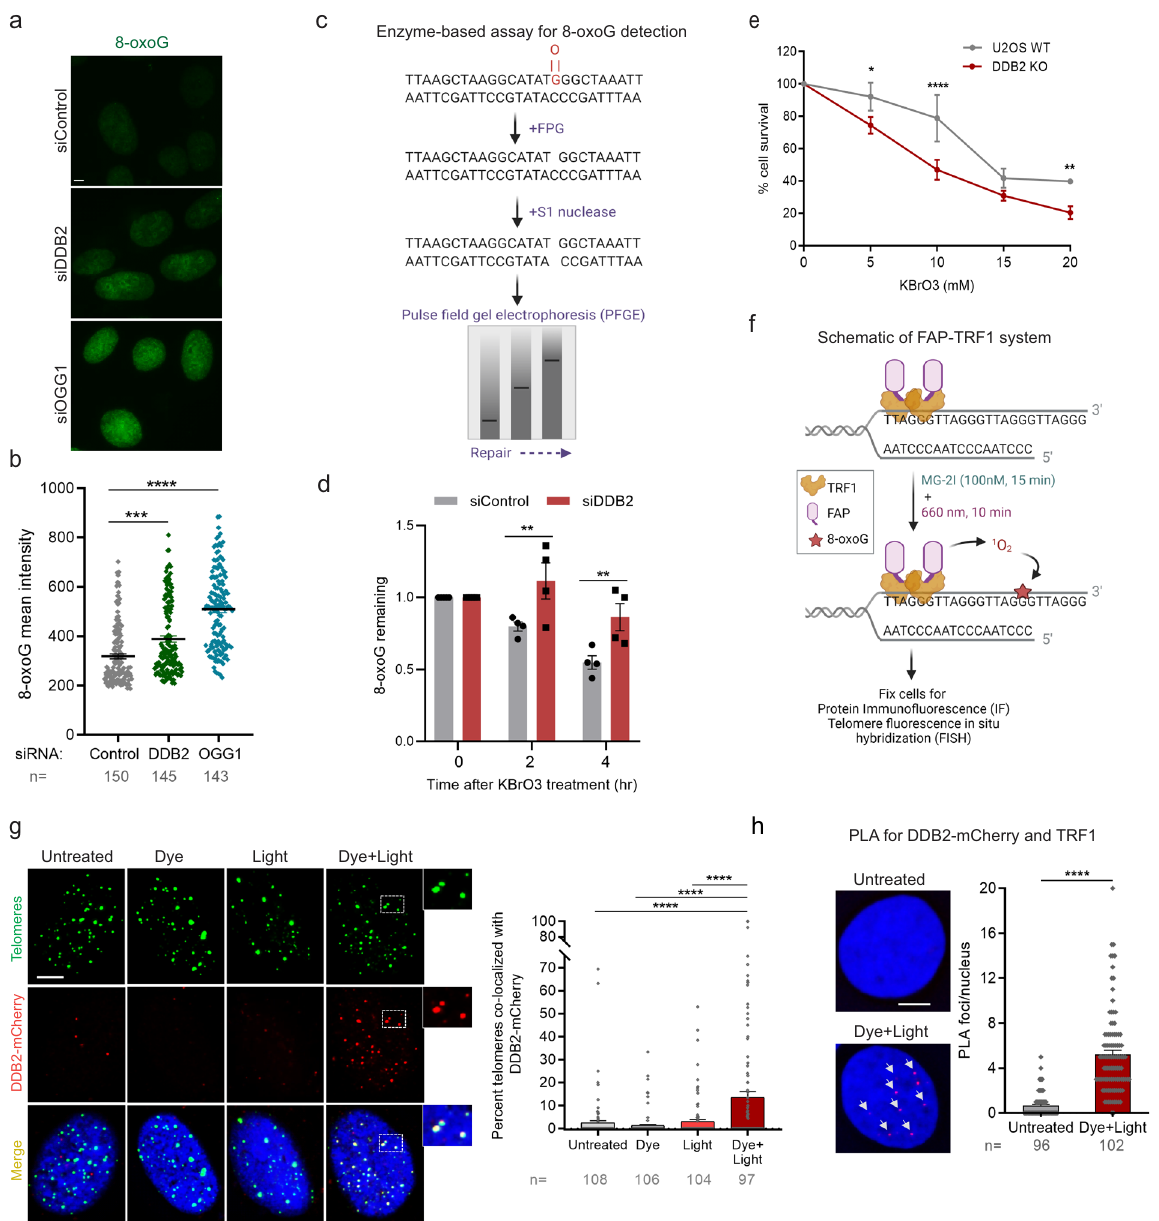
Fig. 1 DDB2 facilitates 8-oxoG repair and is rapidly recruited to sites of 8-oxoG within telomeric DNA. a , b Immuno fl uorescence and quanti fi cation of 8-oxoG in cells transfected with control, DDB2 or OGG1 siRNA. c Schematic of the repair enzyme-based assay for 8-oxoG quanti fi cation in DNA. Genomic DNA containing 8-oxoG is treated with FPG to convert 8-oxoG to one nucleotide gaps. Treating with S1 nuclease converts the gaps to double stranded breaks (DSBs). The cleaved DNA is subjected to pulse fi eld gel electrophoresis (PFGE) to track repair, as damaged DNA migrates faster than repaired DNA. d Quanti fi cation of 8-oxoG repair in U2OS cells transfected with control or DDB2 siRNA and treated with KBrO3. e Clonogenic cell survival curves in U2OS WT and DDB2 knockout (KO) cells treated with a range of concentrations of KBrO3. f Schematic of dye plus light treatment. Cells stably expressing FAP-TRF1 were treated with dye (100 nM, 15 min) plus light (660 nm, 10 min) to introduce 8-oxoG lesions at telomeres. g (left) Recruitment of DDB2- mCherry to 8-oxoG sites at telomeres in untreated, dye alone, light alone, and dye plus light treated cells. (right) Percentage telomeres colocalized with DDB2-mCherry. h Proximity ligation assay (PLA) for DDB2-mCherry and TRF1 in untreated cells and cells treated with dye (100 nM, 15 min) plus light (660 nm, 10 min). Data ( a , b , d , g , h ) represent mean ± SEM from two to three independent experiments. “ n ” represents the number of cells scored for each condition. Data ( e ) shows one representative experiment (performed in triplicate) from three independent experiments, mean ± SD. One-way ANOVA (Sidak multiple comparison test) ( b , g ), Student ’ s two-tailed Student ’ s t -test ( h ) and two-way ANOVA (Sidak multiple comparison test) ( d , e ) were performed for statistical analysis: * p < 0.05, ** p < 0.01, **** p < 0.0001, ns Not signi fi cant. Scale: 5 µ m. Source data are provided as a Source Data fi le. (See also Supplementary Fig. 1 and